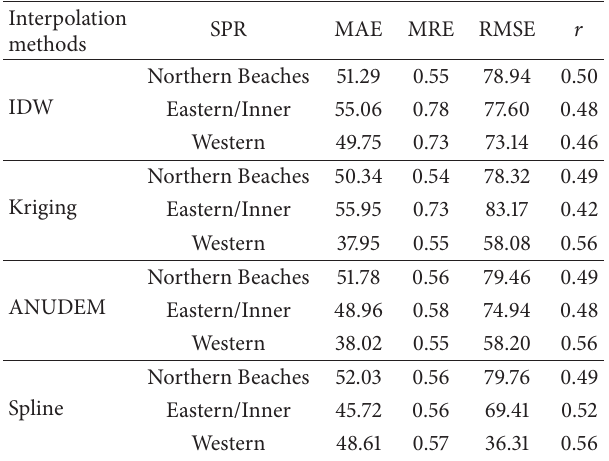
Table 3: Error assessment of interpolated monthly rainfall in state plan regions.